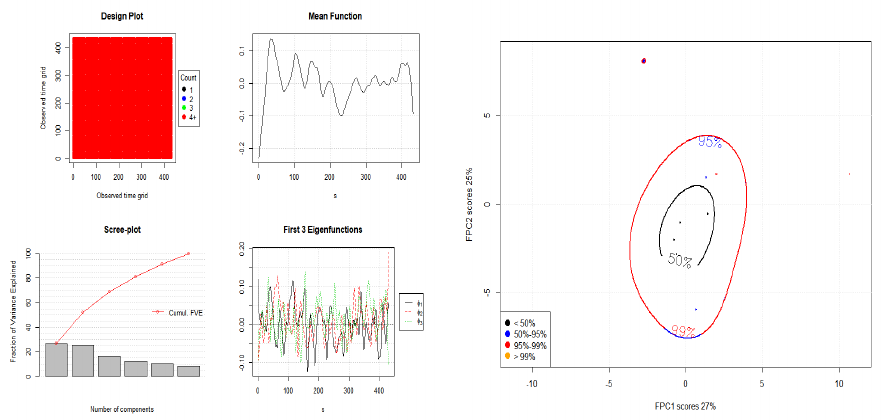
Figure 10. FPCA plots of Asia (1/4/2013 to